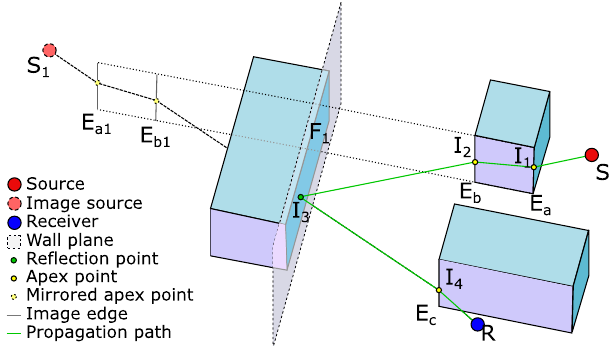
Figure 1. Propagation path along three buildings determined by the image edge